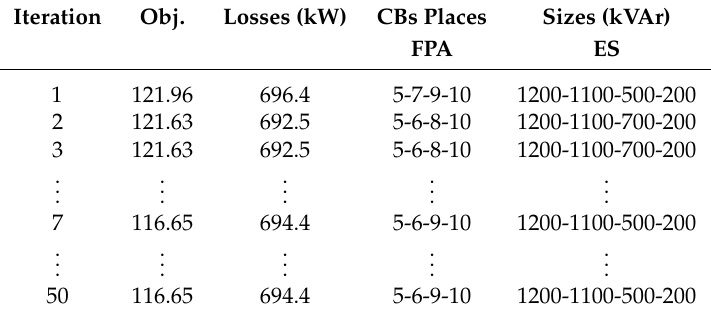
Table 3. Ten-bus system: outline of the optimization